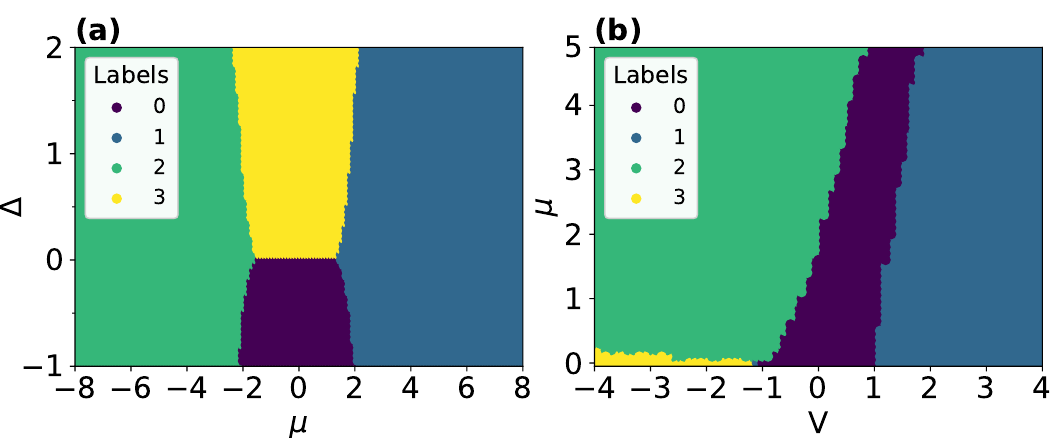
Figure 6: Phase diagrams with k-means . Reconstruction of the phase diagrams of the non-interacting (a) and the interacting (b) models obtained with the labels assigned by k-means. For each data point we plot its label predicted by k-means running with k = 4, the value chosen according to the best silhouette as explained in the